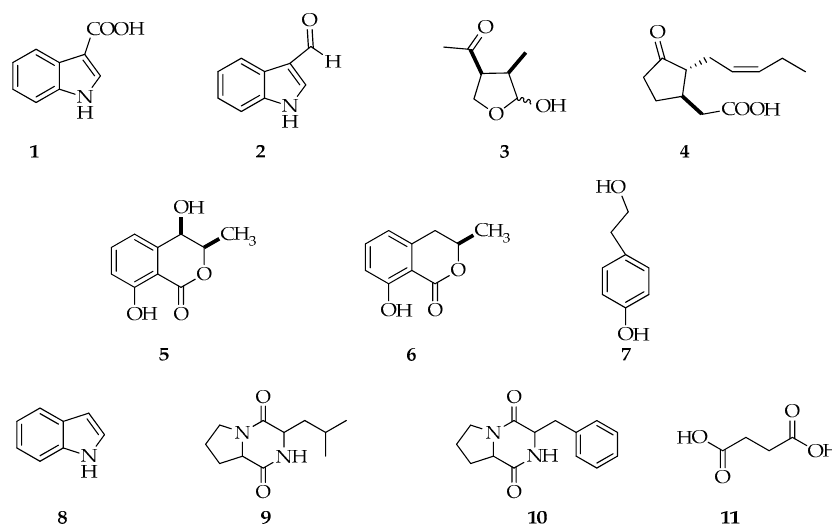
Figure 4. Structures of indole-3-carboxylic acid ( 1 ), 3-indolecarboxaldehyde ( 2 ), (3 R ,4 S )-botryodiplodin ( 3 ), ( − )-jasmonic acid ( 4 ), (3 R ,4 R )-4-hydroxymellein ( 5 ), ( R )-mellein ( 6 ), tyrosol ( 7 ), indole ( 8 ), cyclo -(Pro-Leu) ( 9 ), cyclo -(Pro-Phe) ( 10 ), succinic acid ( 11 ), compounds produced by Lasiodiplodia theobromae LA-SOL3 and LA-SV1 grown in the presence (10 mM) and absence of γ -aminobutyric acid (GABA).